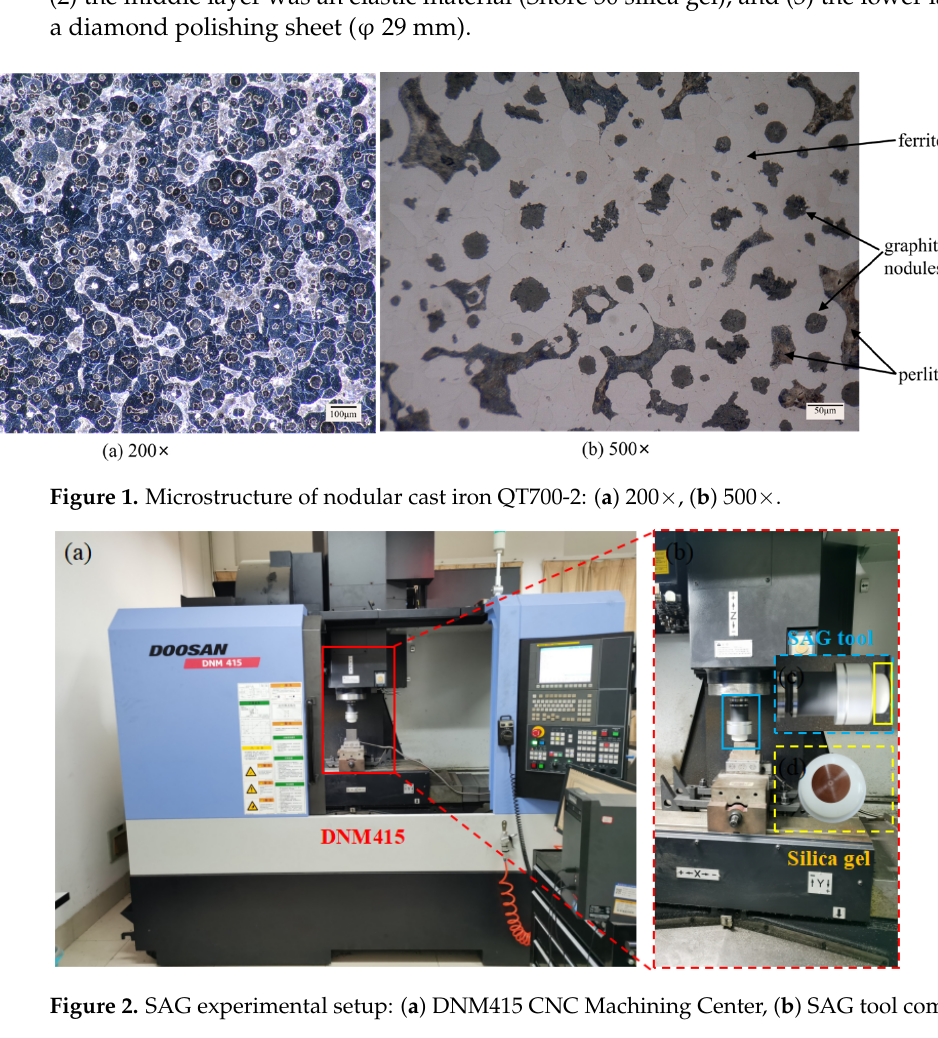
Table 2. Parameters in shape adaptive grinding